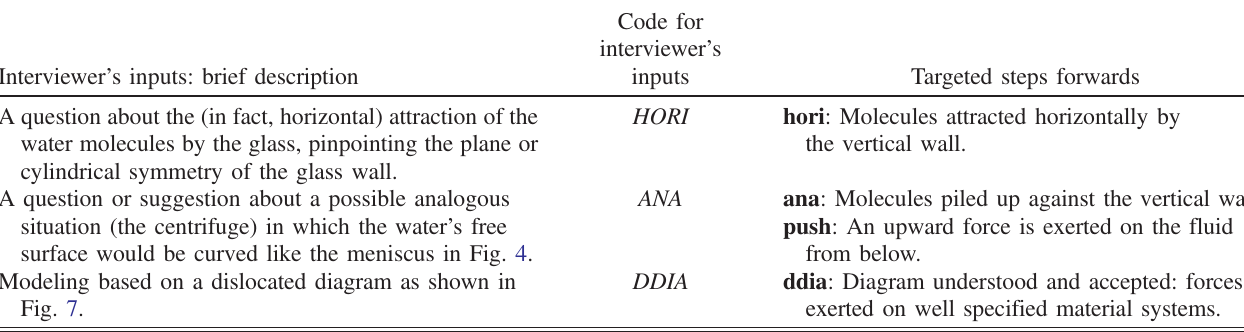
TABLE IV. Codes for the interviewer ’ s main inputs and targeted conceptual steps forward in interviewees.